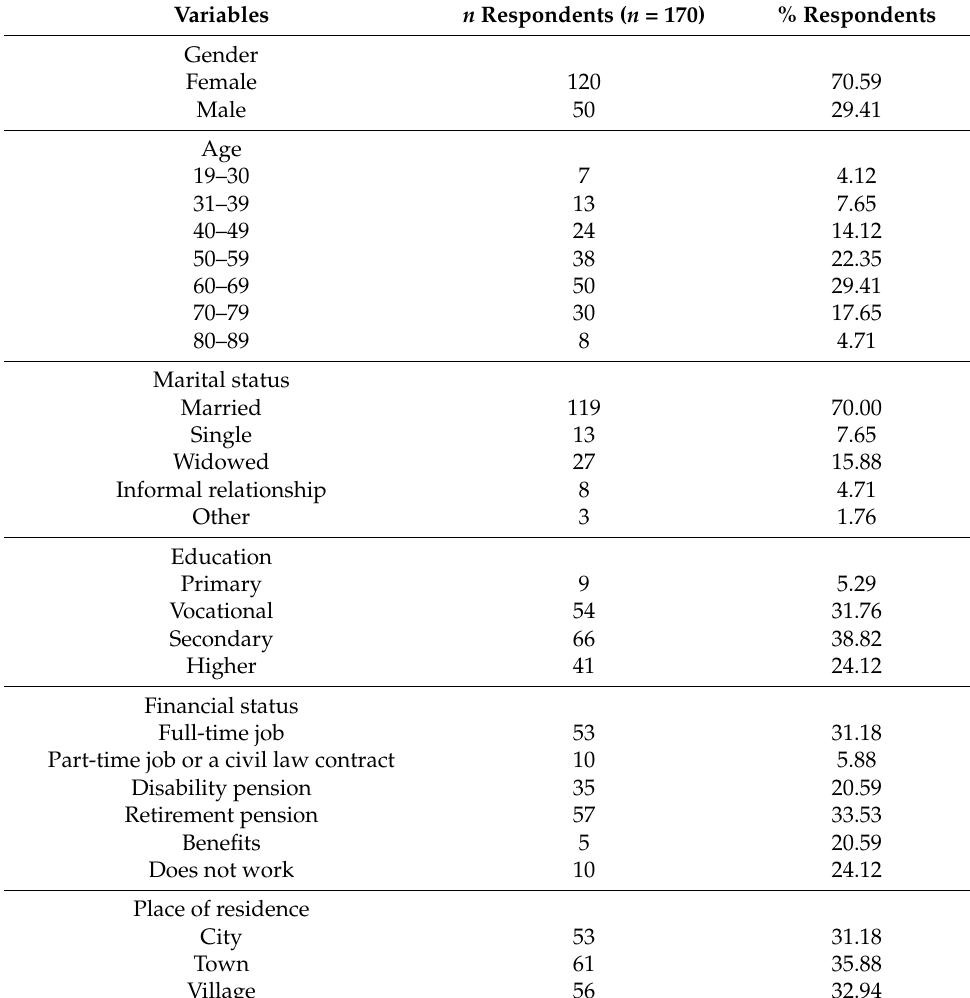
Table 2. Sociodemographic characteristics of the experimental